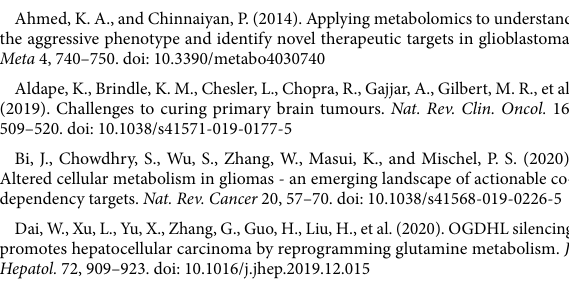
SUPPLEMENTARY FIGURE S2 Classification of patients according to tryptophan metabolic gene expression profile. (A,B) Consensus clustering cumulative distribution function (CDF) for k=2 to k=9. Relative change in the area under the CDF curve for k=2 to k=9. SUPPLEMENTARY FIGURE S3 Expression of the marker gene (IL4I1,CYP1A1,OGDHL and ASMT) in the validation set. (A) The expression of marker genes in the GSE4290 dataset. (B) The expression of marker genes in the GSE15824